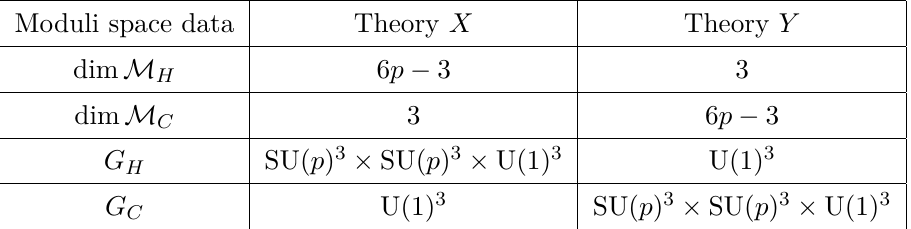
Table 11 . Summary table for the moduli space dimensions and global symmetries for the mirror pair in figure